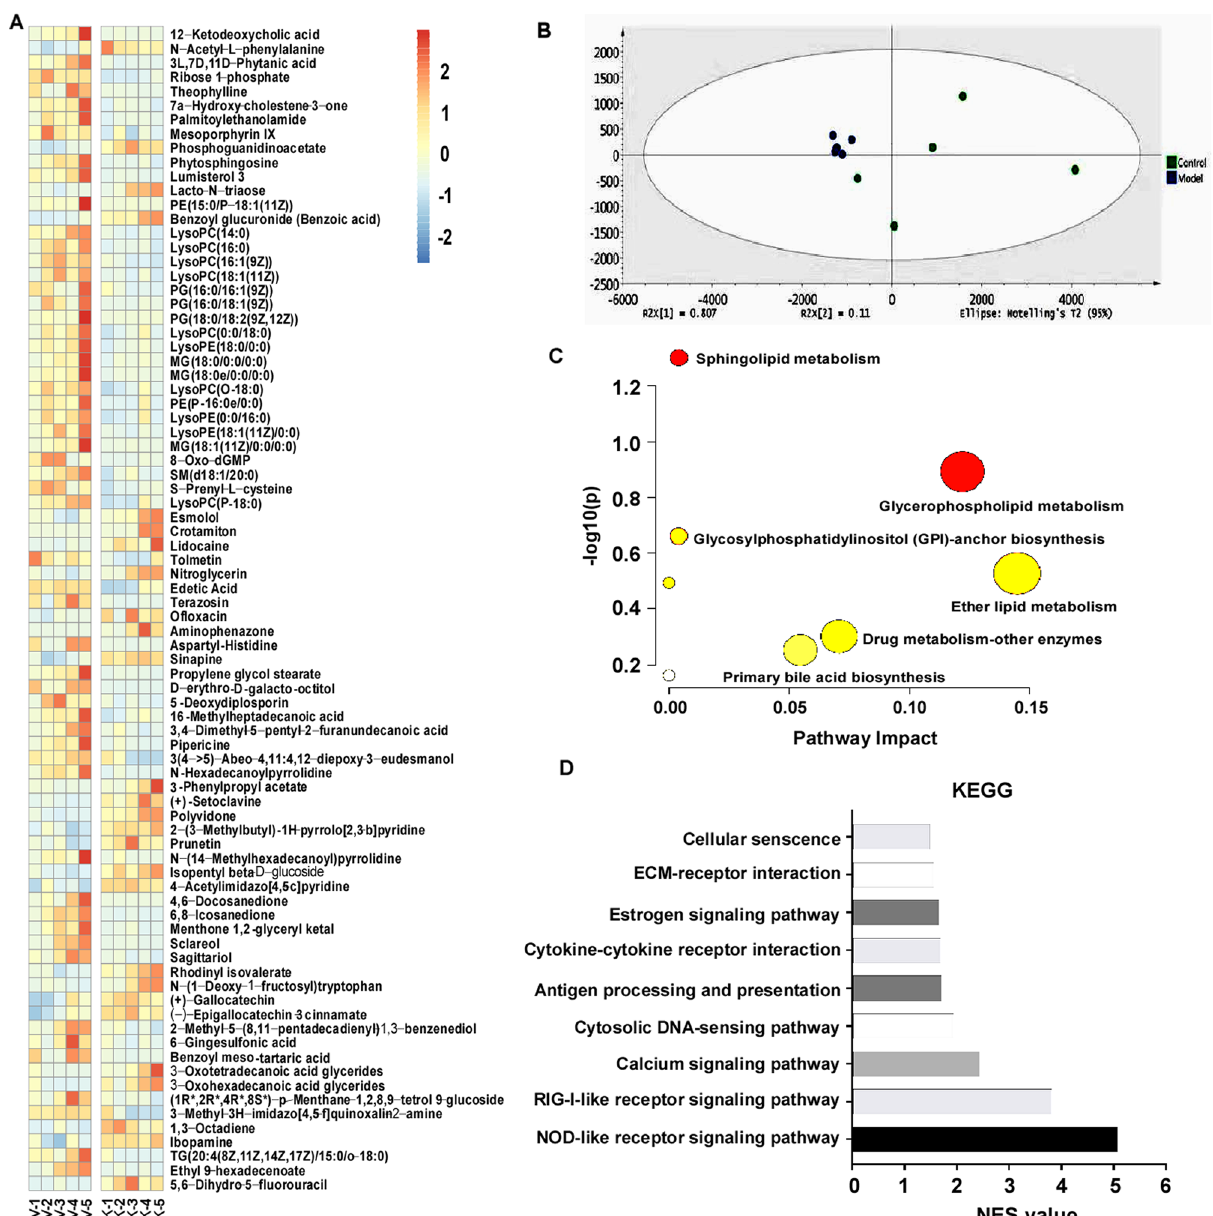
Figure 8. Metabolomic results and related bioinformatic analysis in KLF15-overexpressing BT549 cells. ( A ) Heatmap showing relative concentrations differences of metabolites within KLF15 and vector groups. With p < 0.05 and fold change > 2. V1–V5: Control group, K1–K5: Model group. ( B ) Score scatter plot of PCA analysis of the control and model groups based on metabolites with p < 0.05 and fold change > 2. ( C ) Pathway analysis of the metabolites with p < 0.05 and fold change > 2. D. KEGG pathway analysis of KLF15 regulation of antitumor pathways in breast